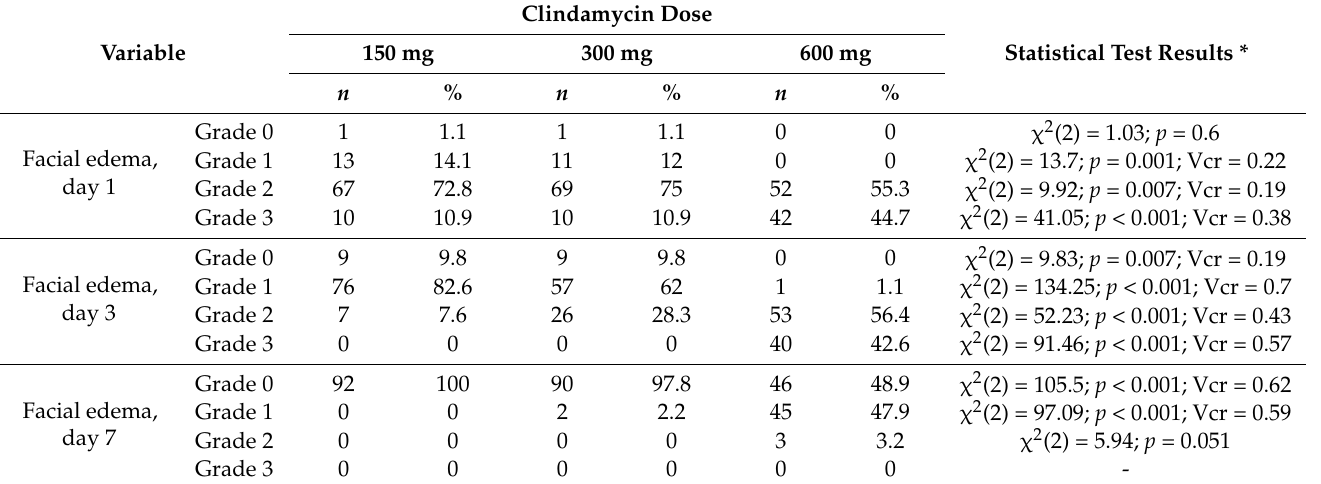
Table 3. Facial edema in the study groups.